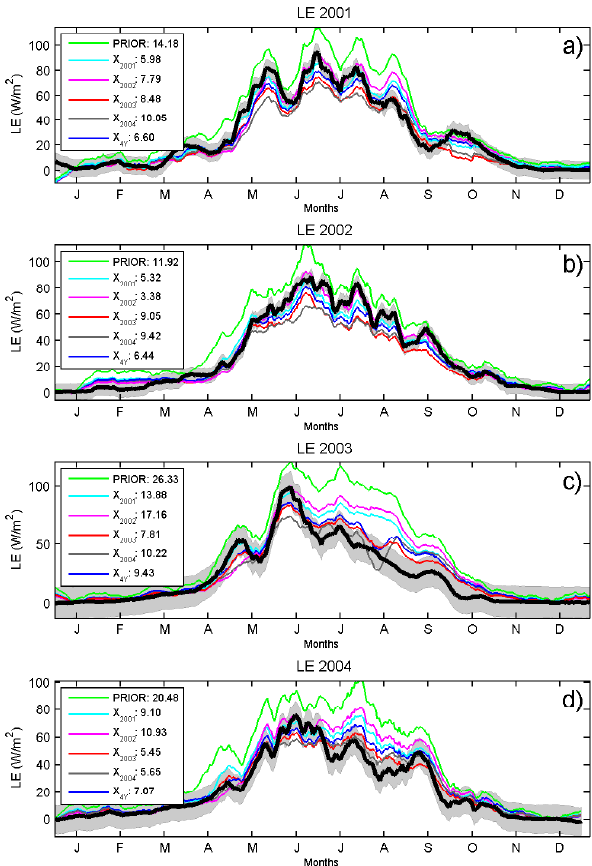
Figure 5. For 2001, 2002, 2003 and 2004, fits to the net CO 2 flux observations (thick black curve) of the model run with the prior and the optimized parameter sets. Figure legends show the model– data RMSE for the different parameter sets. Observation errors are represented by the grey shaded area.